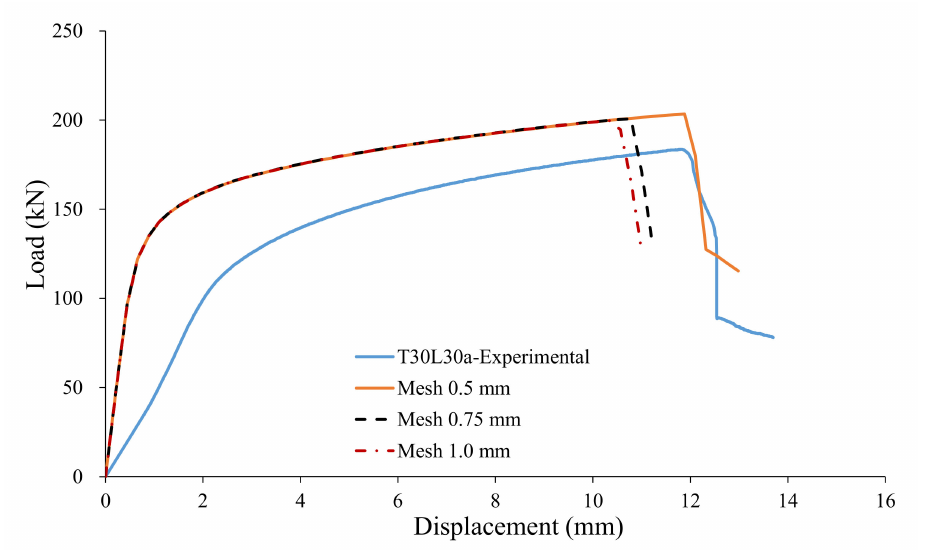
Figure 6. Mesh sensitivity analysis for Model